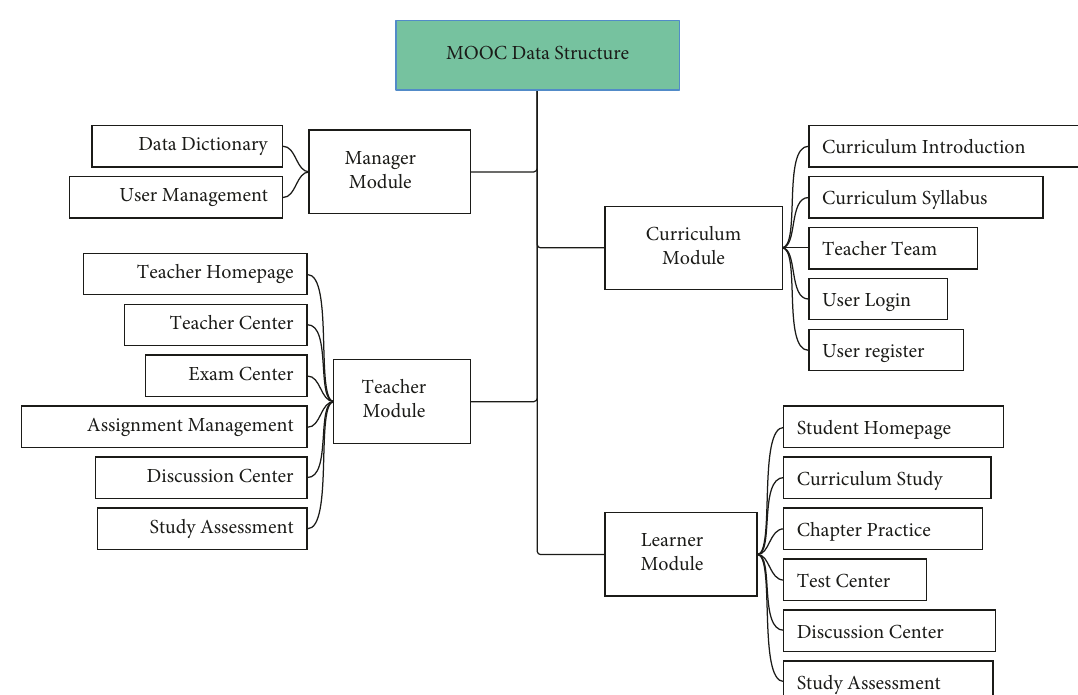
Figure 6: Overall functional design diagram of the